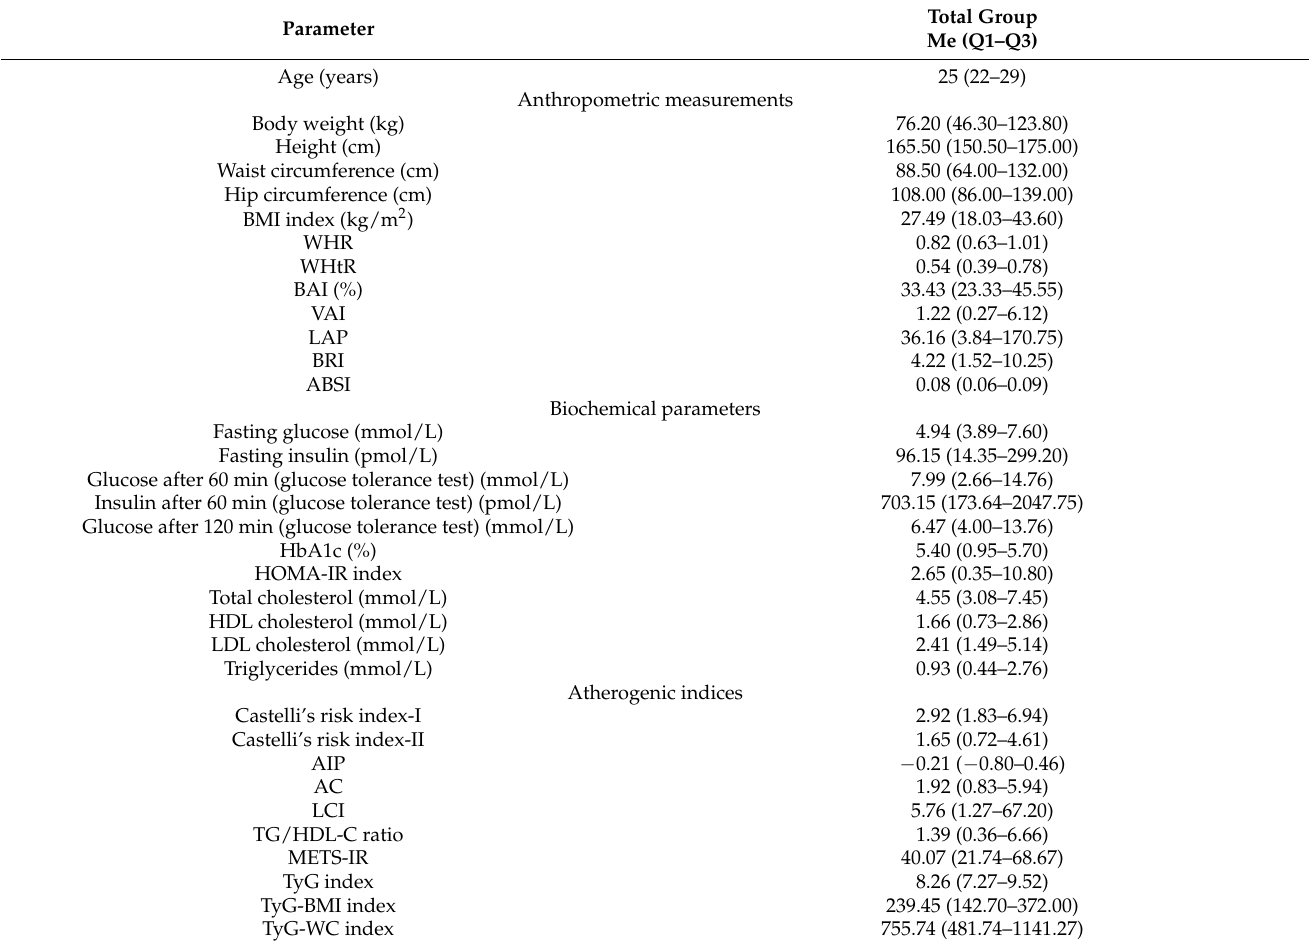
Table 1. Baseline anthropometric measurements, clinical and laboratory